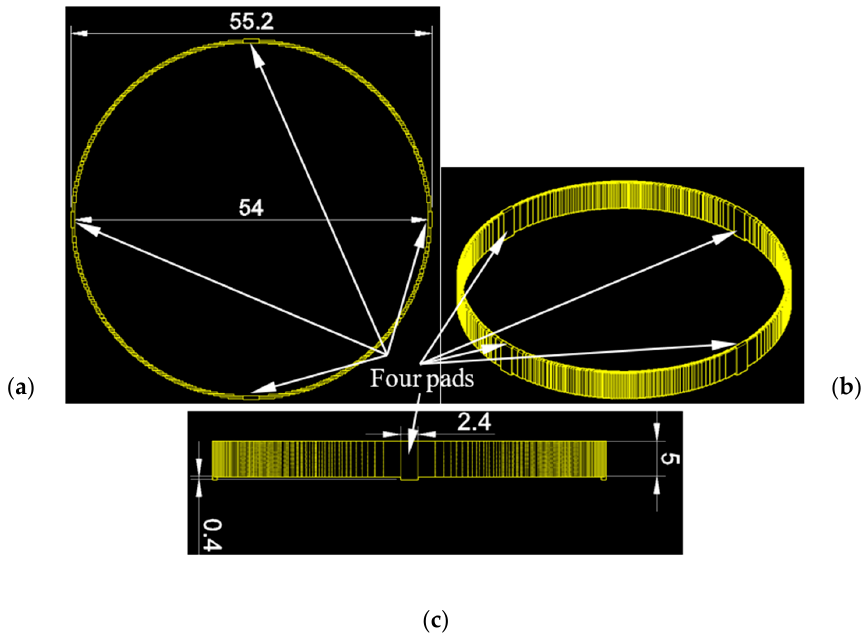
Figure 12. The discretized metallic-ring and its dimensions, ( a ) the top view, ( b ) an isometric view and ( c ) a side view (unit is in mm).